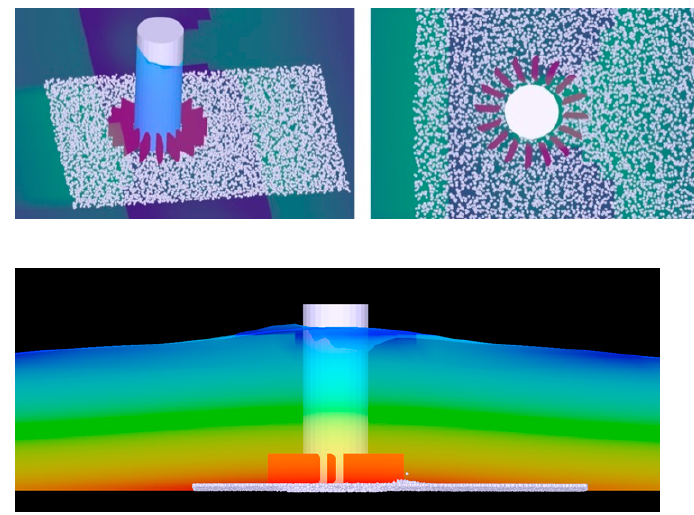
Figure 24. Plan and side view of the bed morphology after exposure to waves for 80 s (hybrid